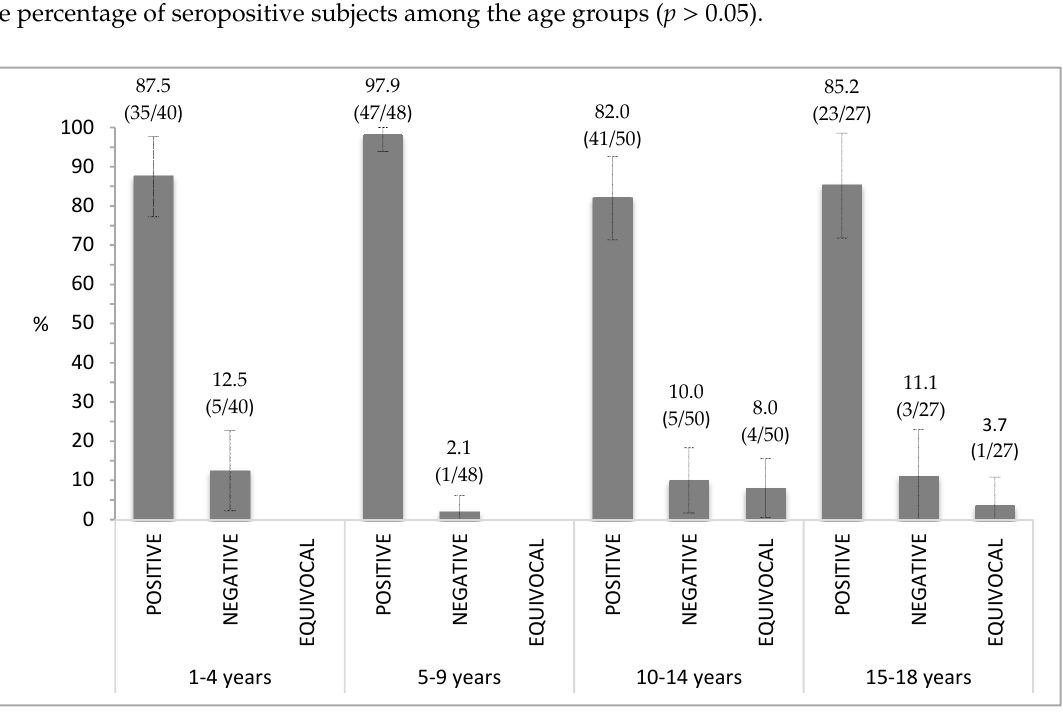
Figure 1. Percentage of measles immunity distribution in the age groups.